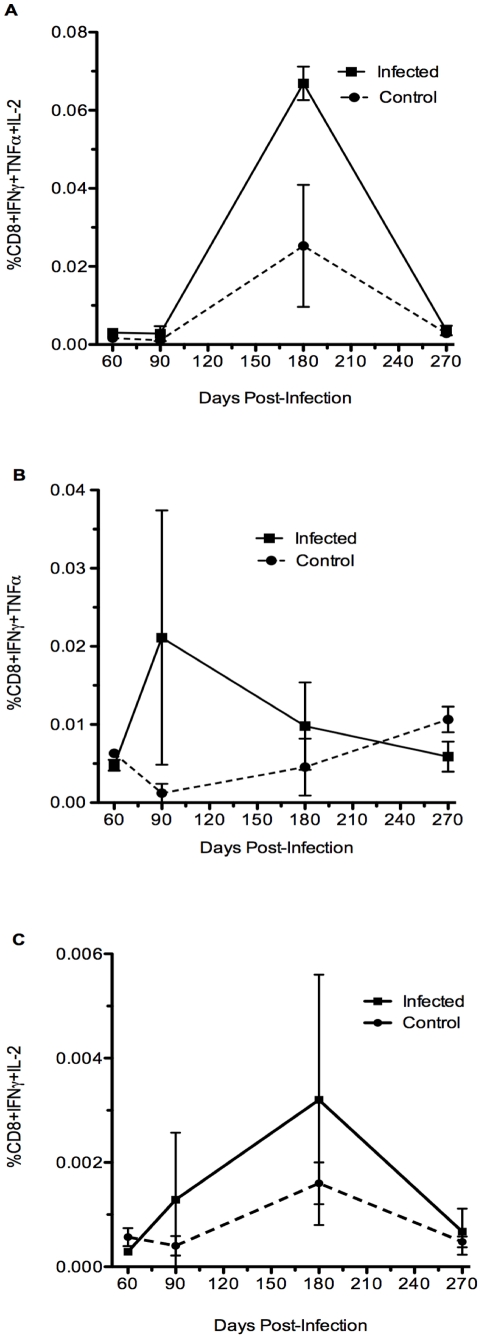
Cytokine co-expression profile of CD8+ T cells expressing 3 or 2 cytokines simultaneously.A) Frequency of polyfunctional splenic CD8+ T cells co-expressing IFN-γ, TNF-α, and IL-2. Expression of 3 cytokines from infected animals was not different from PBS animals over the time of infection, p≤0.06 at 180 days. B) Frequency of dual-function CD8+ T cells co-expressing IFN-γ and TNF-α, p≤0.7 on any day. C) Frequency of dual-function CD8+ T cells co-expressing IFN-γ and IL-2, p≤0.8 on any day.